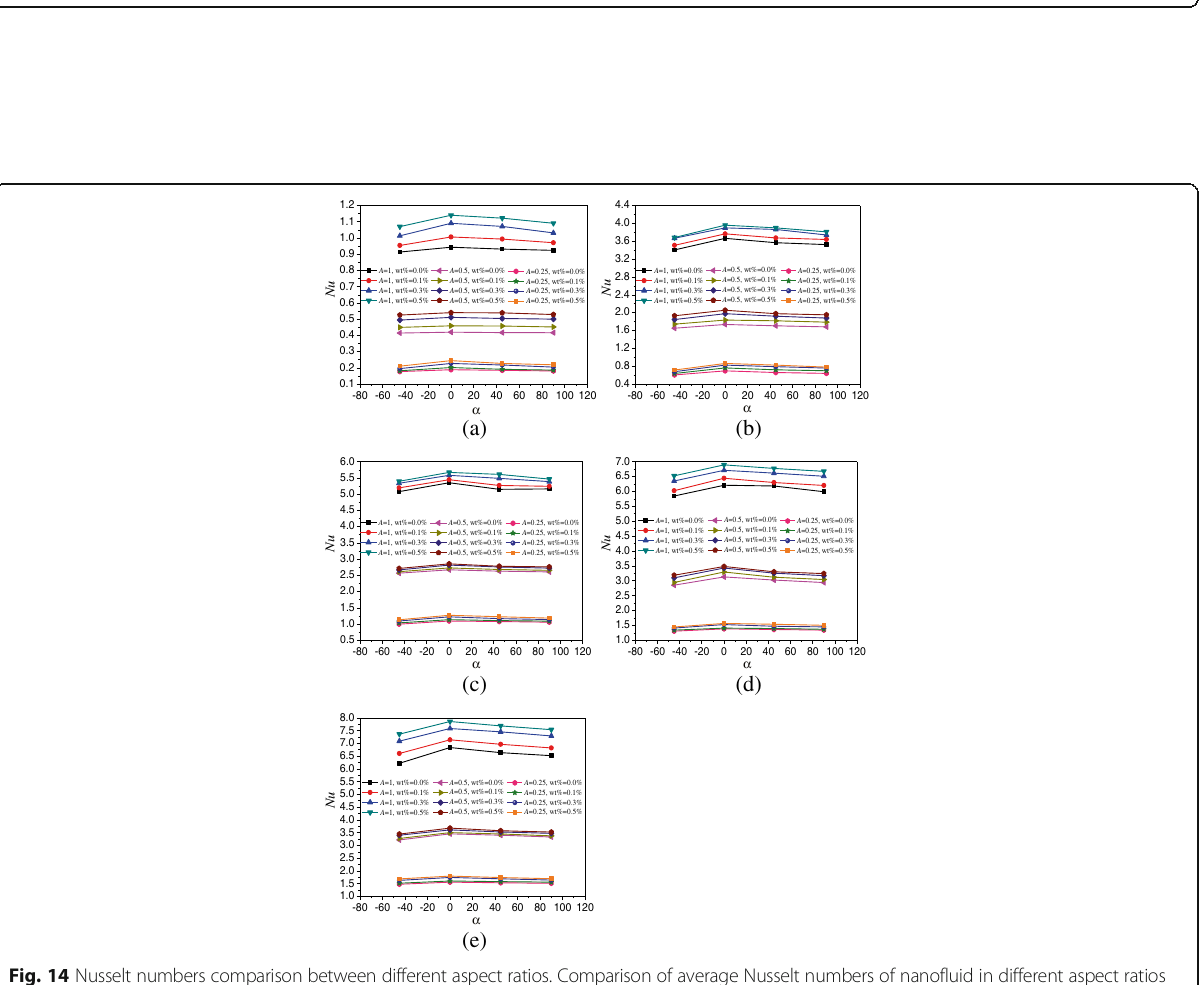
Fig. 13 Changes of Nusselt numbers with heating power ( A = 1:4). Average Nusselt numbers changes of nanofluid in the enclosure ( A = 1:4) with heating power at different rotation angles. a α = − 45°. b α = 0°. c α = 45°. d α =